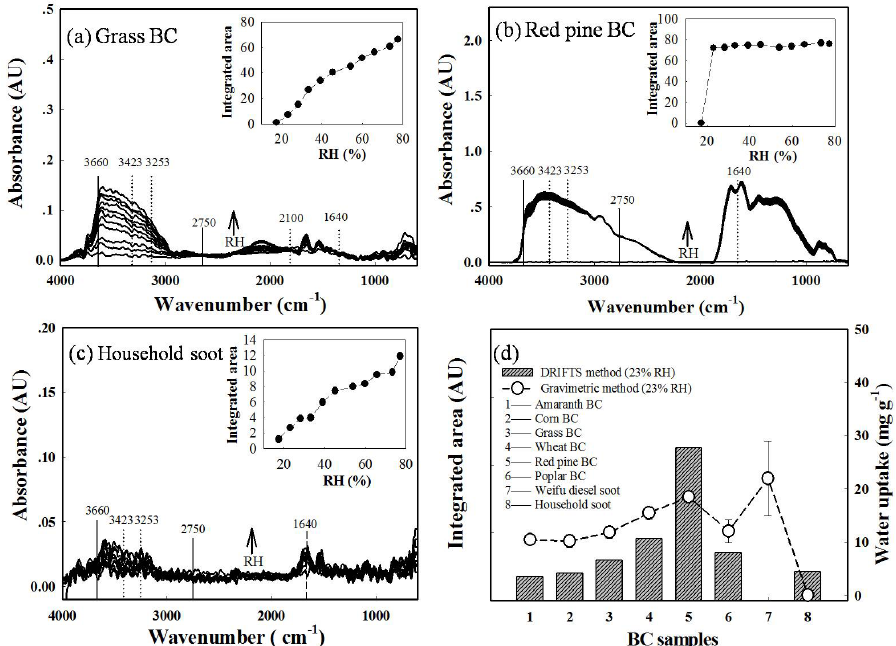
Figure 3. Diffuse reflectance infrared Fourier transform spectroscopy (DRIFTS) characterization of equilibrium water uptake by BCPs. (a–c) Spectra for the three representative BCPs (grass, red pine, and household soot) equilibrated at varying relative humidity (RH) levels. (d) Comparison of equilibrium water uptake measured as integrated area of O − H stretching region (2750–3660cm − 1 ) between eight selected BCPs at 23% relative humidity. Error bars represent standard variations from duplicate samples. Insets in panels (a–c) present water uptake measured as integrated area of O − H stretching region against RH.